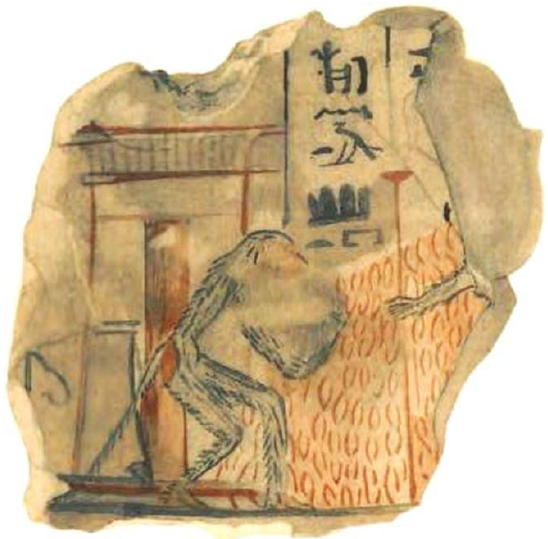
Figure 9. Baboon feeding from heap of grain (EMC inv. no. JE 63799), limestone flake, Deir el-Medina, 19th Dynasty (Illustration taken from Vandier d’Abbadie (1937), pl. 40, courtesy of the Egyptian Museum, Cairo).